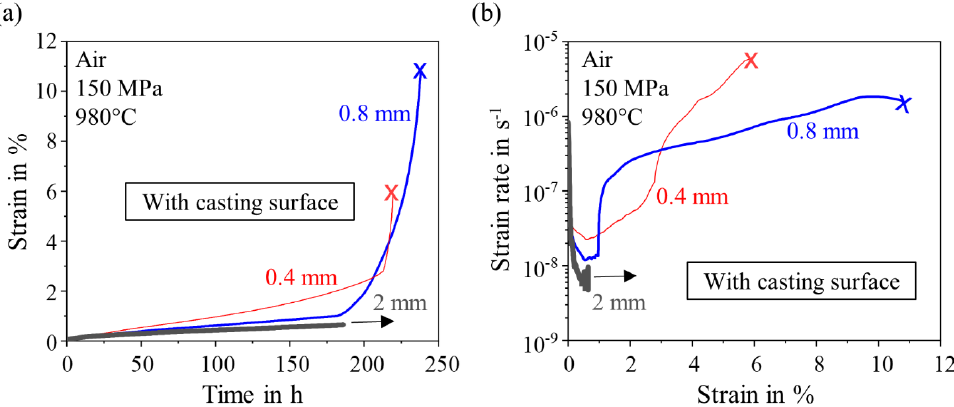
Figure 7. Creep curves of thin-cast specimens with casting surface of different wall thickness in air at 980 °C under a low stress of 150 MPa: ( a ) strain versus time; ( b ) strain rate versus strain.